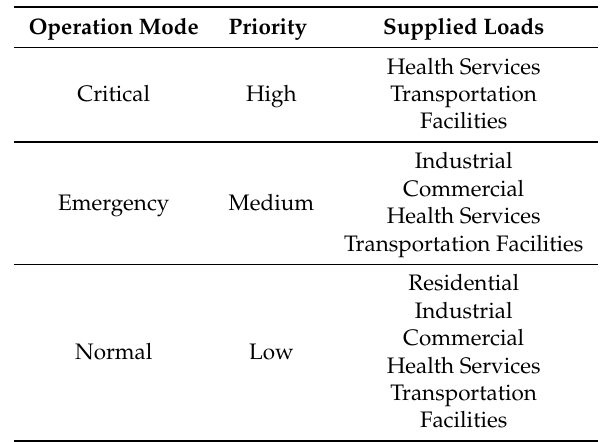
Table 2. Loads scheduled according to microgrid operation